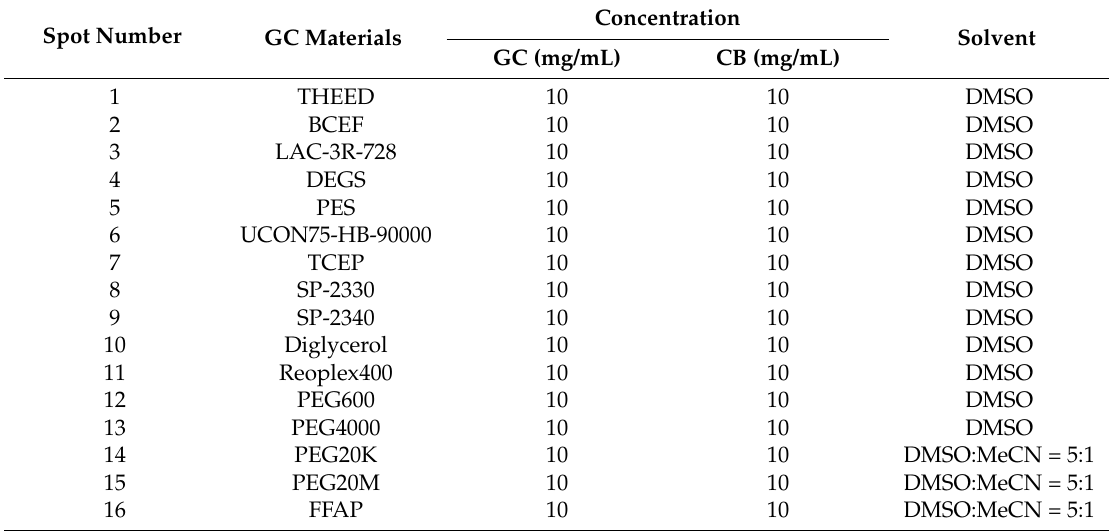
Table 4. Characteristics of the composite materials used for coating the 16-channel chemosensitive resistor